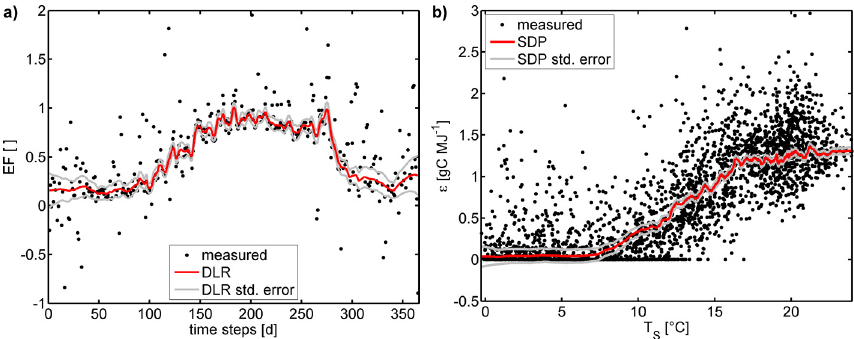
Fig. 1. (a) Example for the application of DLR to estimate the seasonal variation of the evaporative fraction, EF (see Eq. 2). Data from MMSF, 2006. (b) Example for the application of SDP to estimate the evolution of the light use efficiency ( (cid:15) ) depending on the soil temperature. T S (see Eq. 3). Data from MMSF,